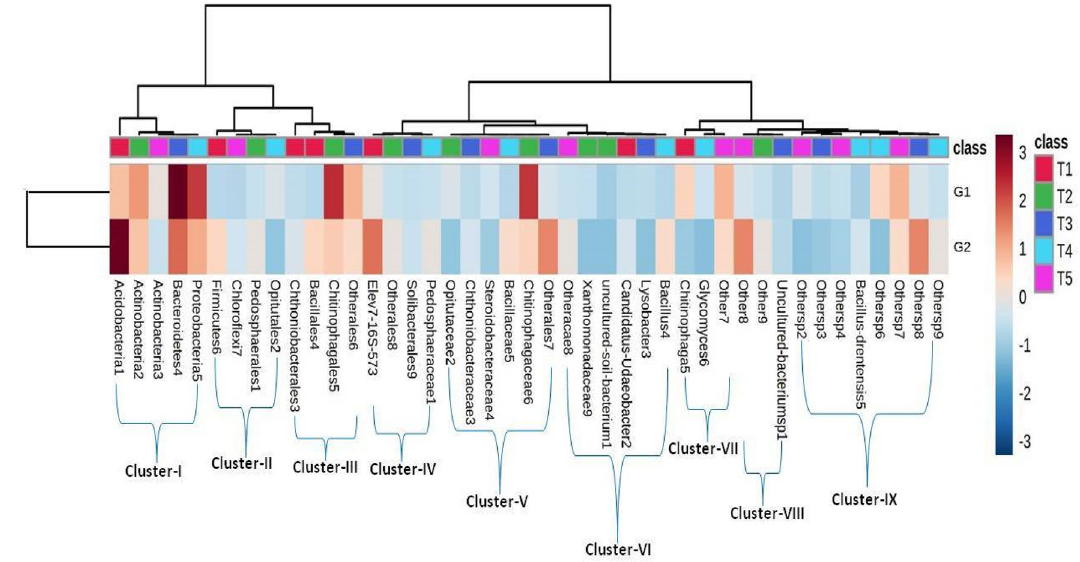
Figure 7. Comparative (G1 organic and G2 conventional) heat map of dominant microbial diversity and their clusters in terms of T1 (phylum), T2 (order), T3 (family), T4 (Genus) and T5